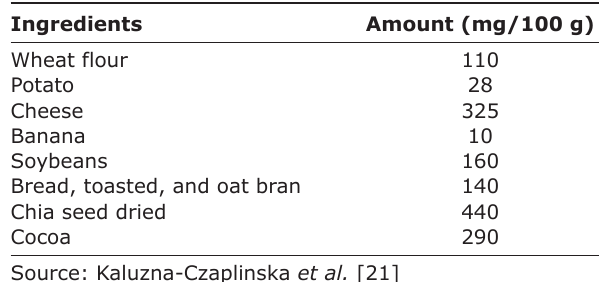
Table-2: The amount of Tryptophan in common ingredients.